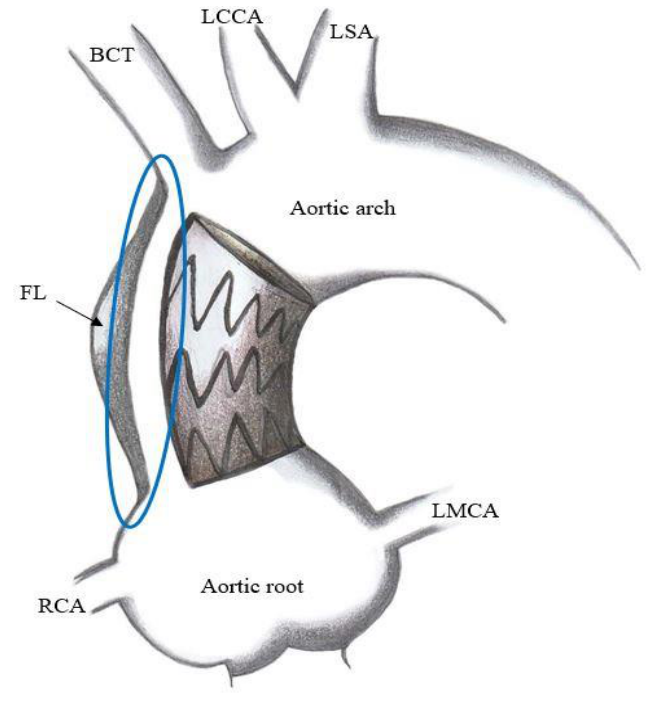
Figure 4. Representation of type A aortic dissection treated with a too short endoprosthesis that does not cover aortic dissection. Blue circle indicate the areas of dissection uncovered by endoprosthesis. BCT = brachiocephalic trunk; FL = false lumen; LCCA = left common carotid artery; LMCA = left main coronary artery; LSA = left subclavian artery; RCA = right coronary